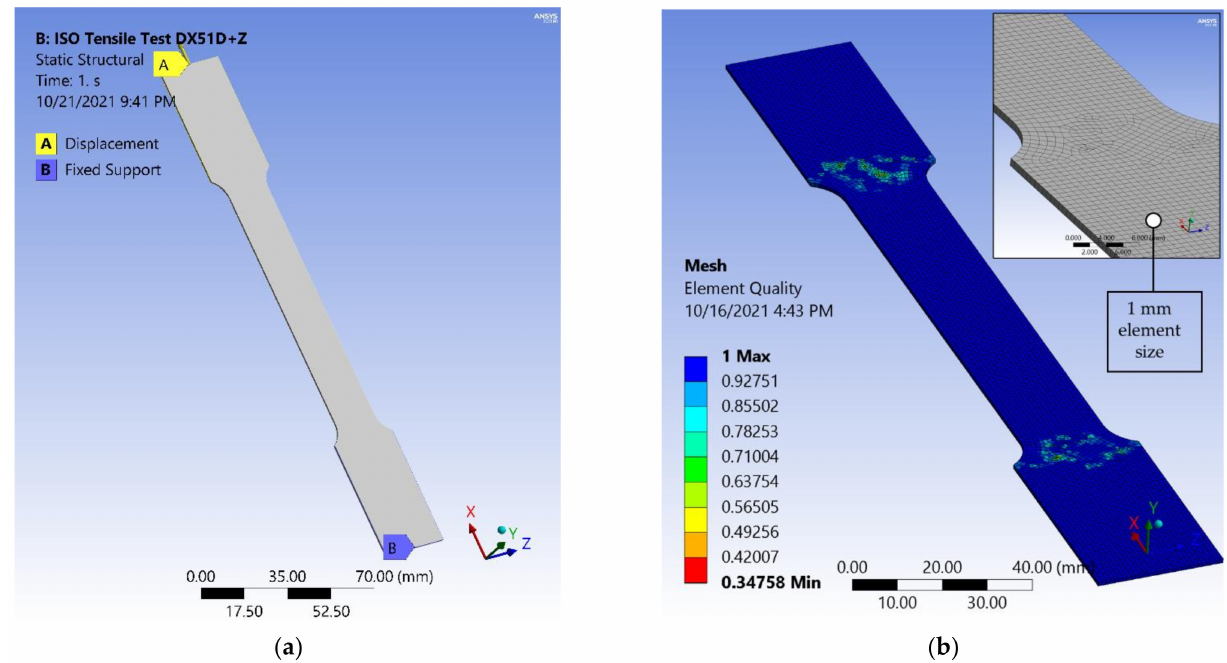
Figure 19. Finite Element Model for tensile stress–strain test calibration: ( a ) loading schema; ( b ) mesh element quality discretization and detail.